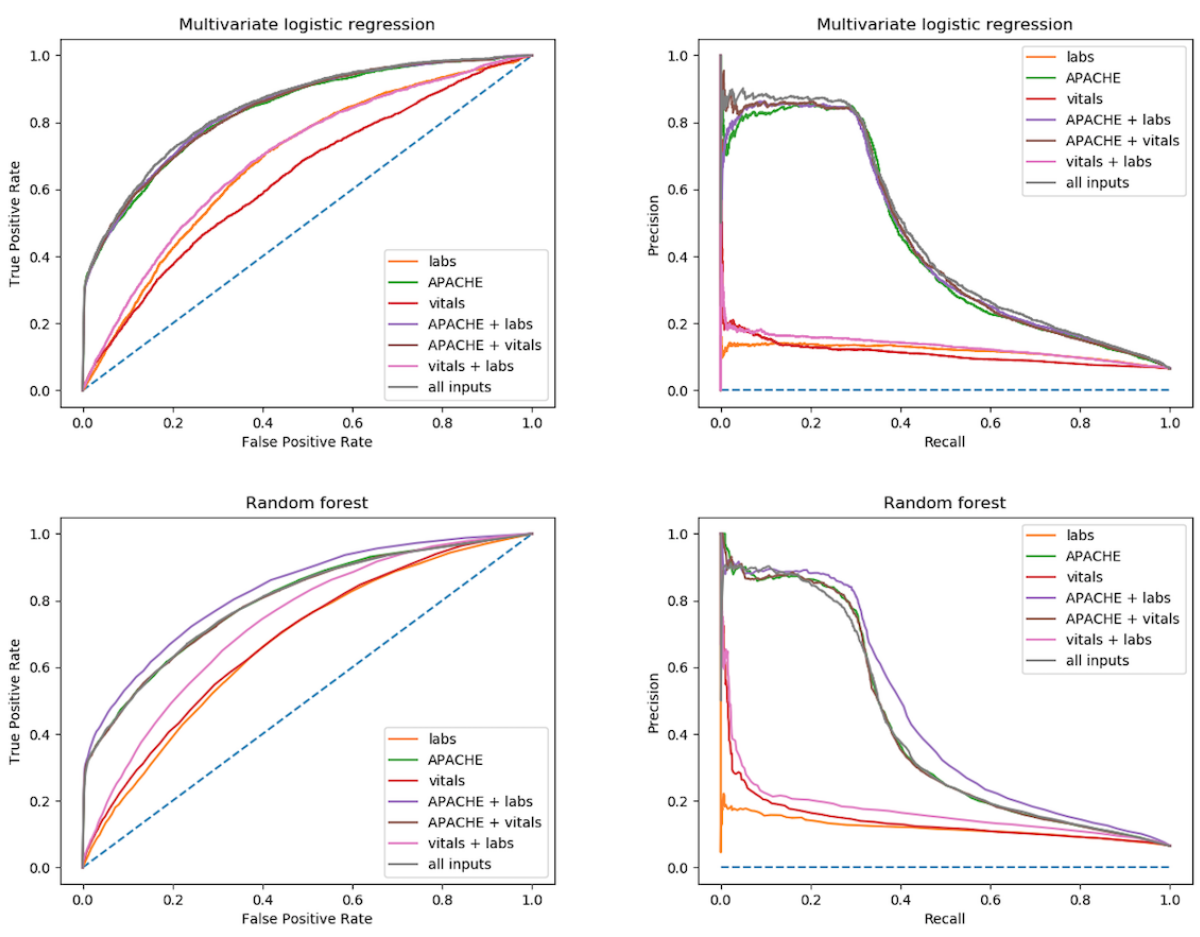
Figure 2. Nonrisk factor patients (patients presenting to the intensive care unit without risk factor of heart failure) area under receiver operating characteristic curve and precision-recall curve for both multivariate logistic regression and random forest models. Each curve represents a different model input combination. Vital signs data extraction window was held constant at 360 minutes for all inputs. APACHE: Acute Physiology and Chronic Health